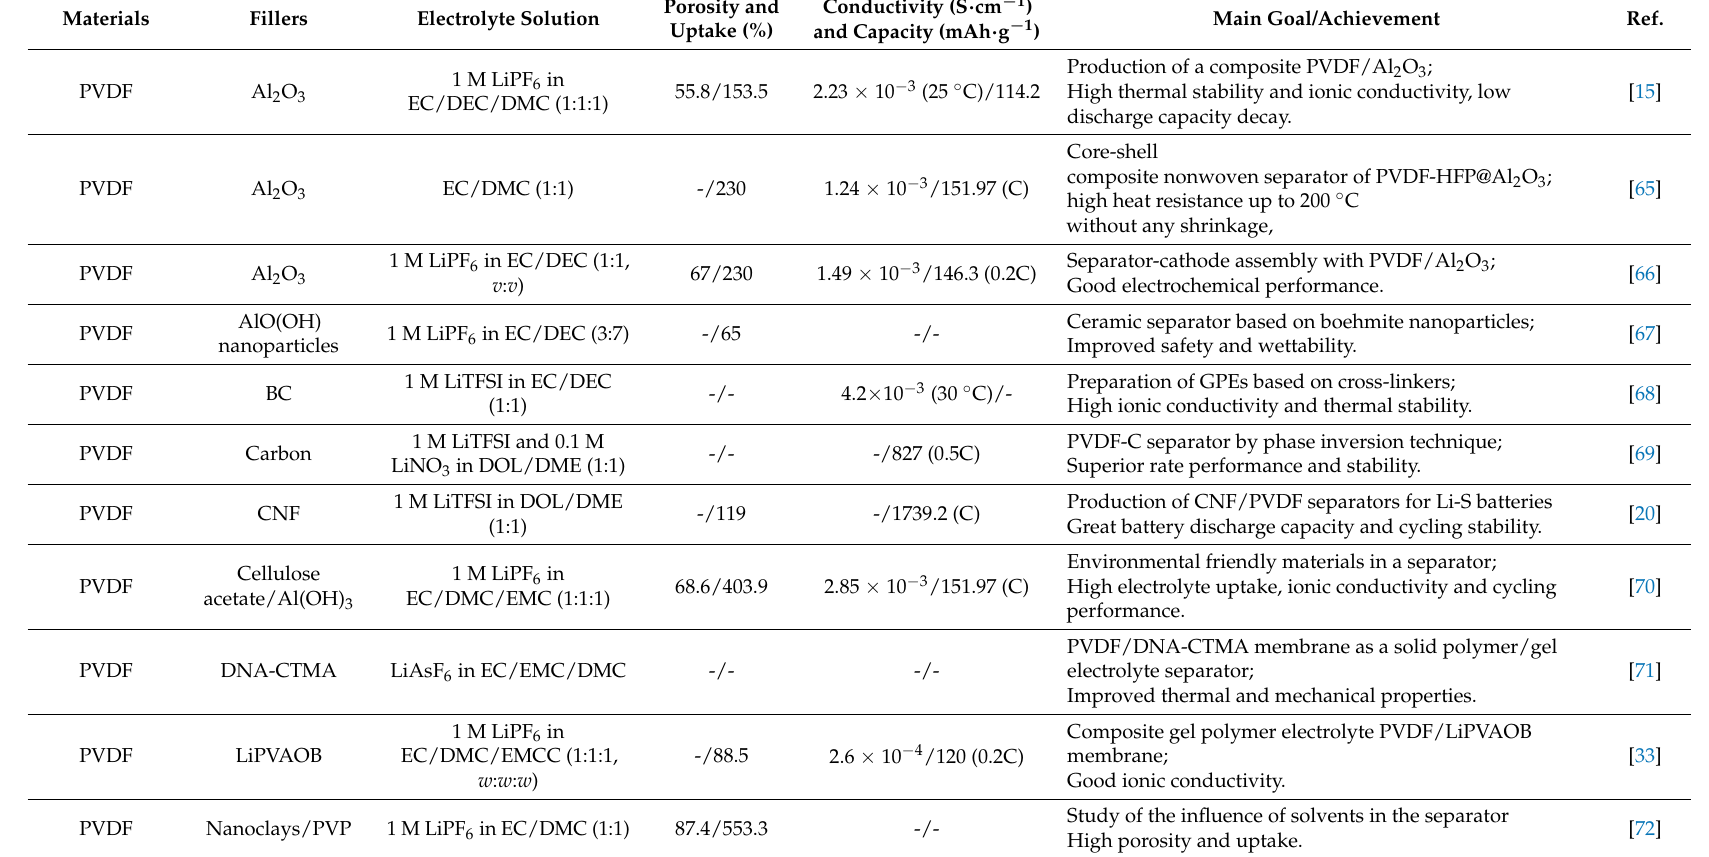
Table 5. Polymer composites based on PVDF and co-polymers with main properties, goal, and